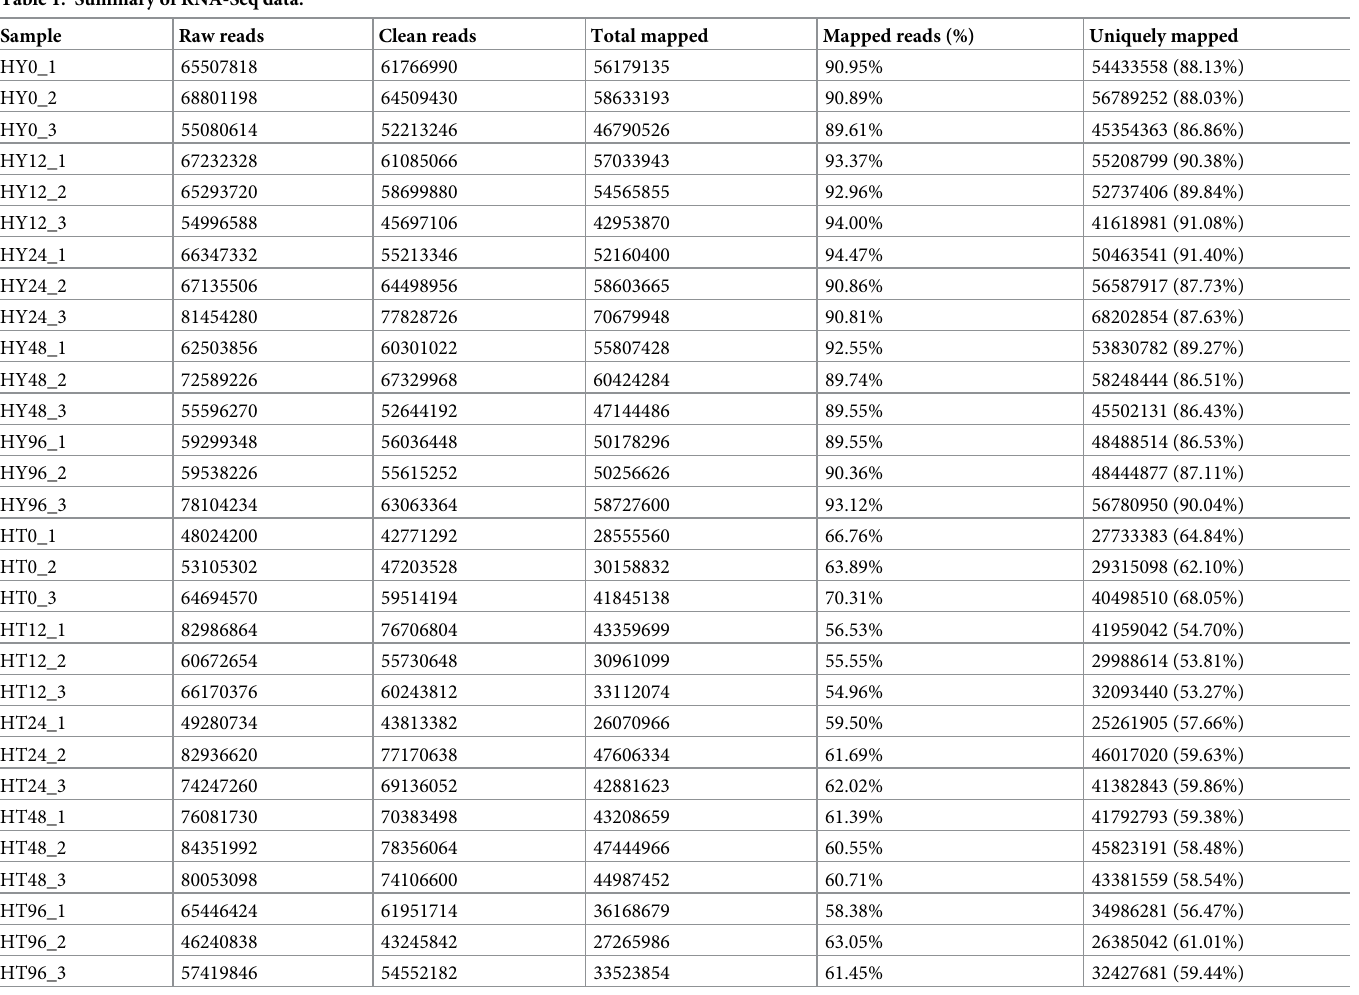
Table 1. Summary of RNA-Seq